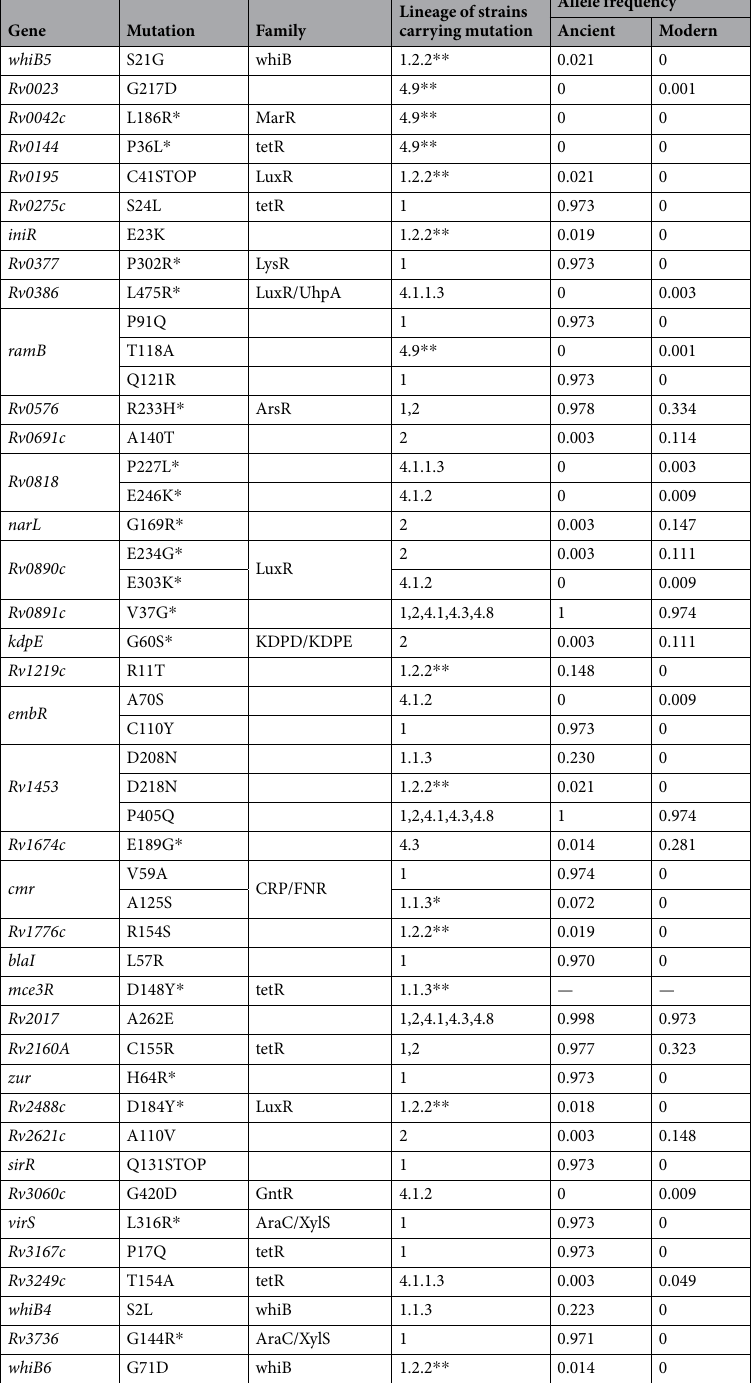
Table 2. Non-synonymous variants in transcriptional regulatory genes with eQTL associations, with potential functional impairment. Table showing non-synonymous mutations in transcriptional regulatory genes found as potential eQTLs. * Sorting Intolerant from tolerant (SIFT) predicted scores ( p value) < 0.05 and considered to have functional impact; whilst for the others the SIFT software was unable to predict functional effects of mutations; ** Only one or two samples available from the lineage. Allele frequency refers to the fraction of strains harbouring the SNP in a larger data set (n = 6,218) 26